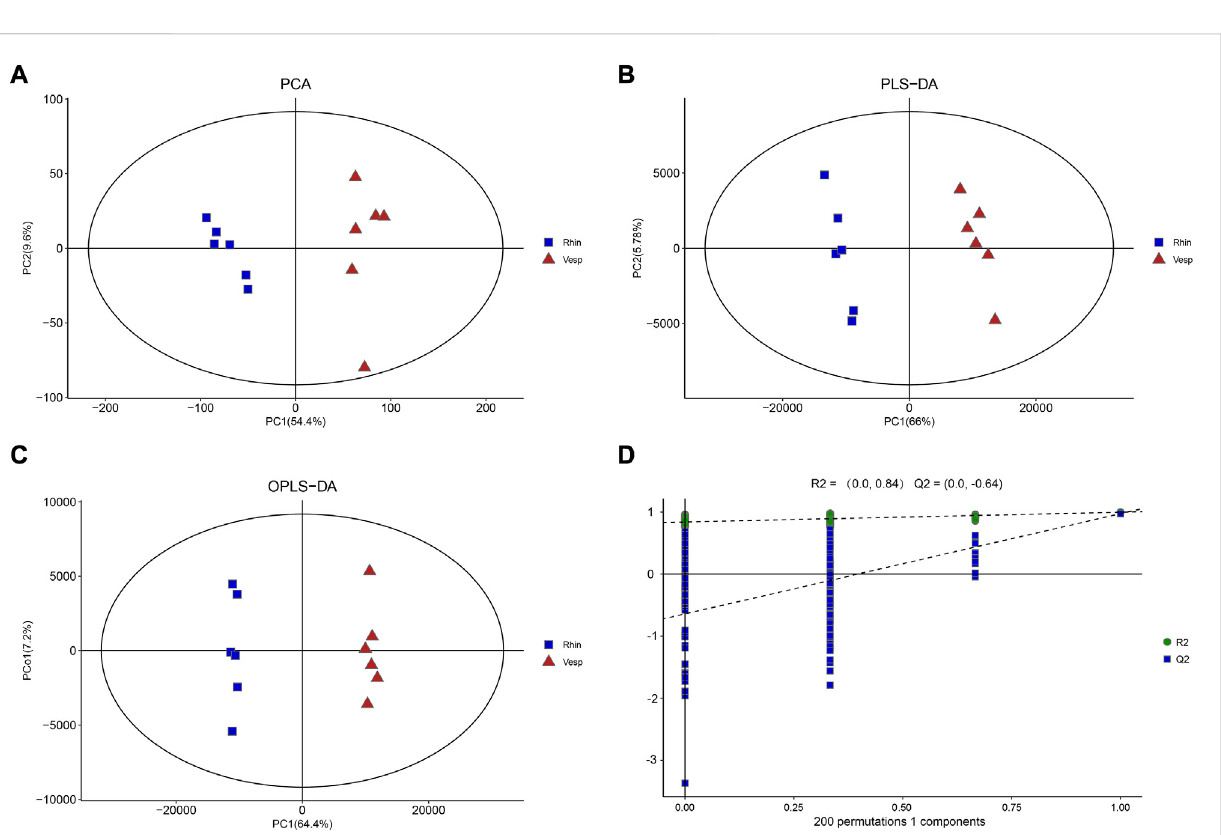
FIGURE 1 Resultsofmultivariateanalysisofcochlearsamplesfromthe R.sinicus ,and V.sinensis . (A) PCAscoreplot, (B) OPLS-DAscoreplot, (C) PLS-DAscore plot, (D) permutation plot. There is a clear separation of R. sinicus , and V. sinensis